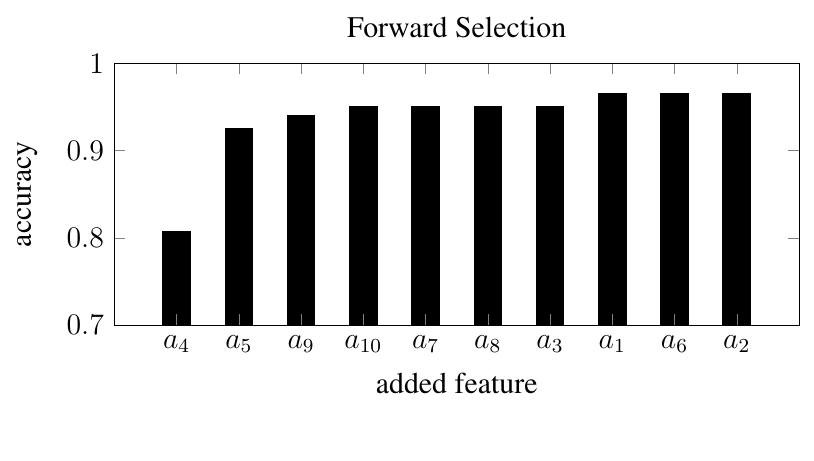
Figure 9. Results of the feature selection process using forward selection. The x tick label specifies the feature that has been added to the subset to the left.